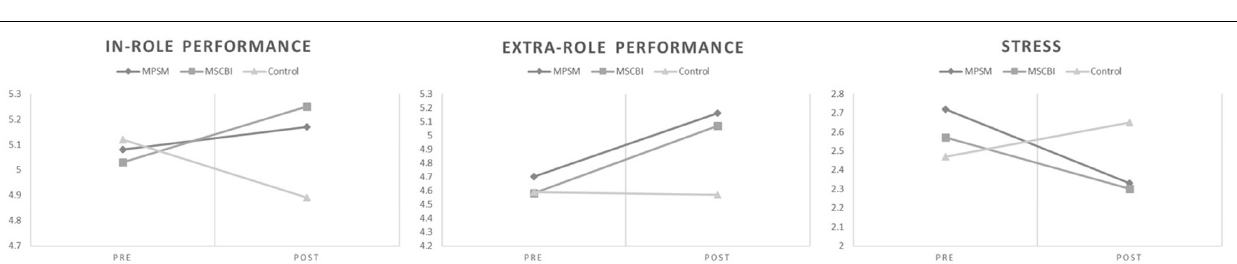
FIGURE 4 | Means estimated for the MBSR group, MPSM group, and control group on pre-intervention and post-intervention time points, for performance dimensions and perceived stress with statistically significant interaction